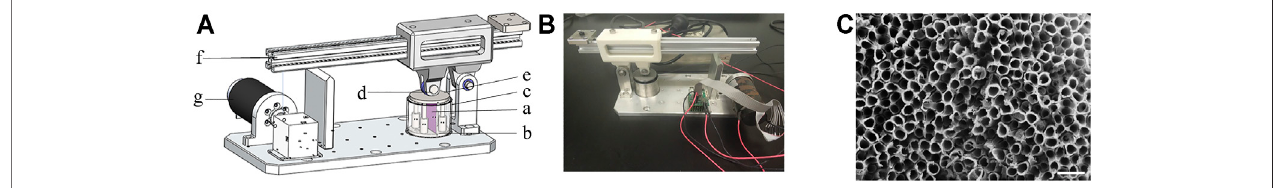
FIGURE 1 | Cyclic mechanical loading device and TiO 2 nanotubes topography. (A) The diagrams of the mechanical loading device. (B) Picture of the real product. (C) Surface titanium dioxide nanotubes are approximately 80 nm in diameter. Scale bars: 200 nm.